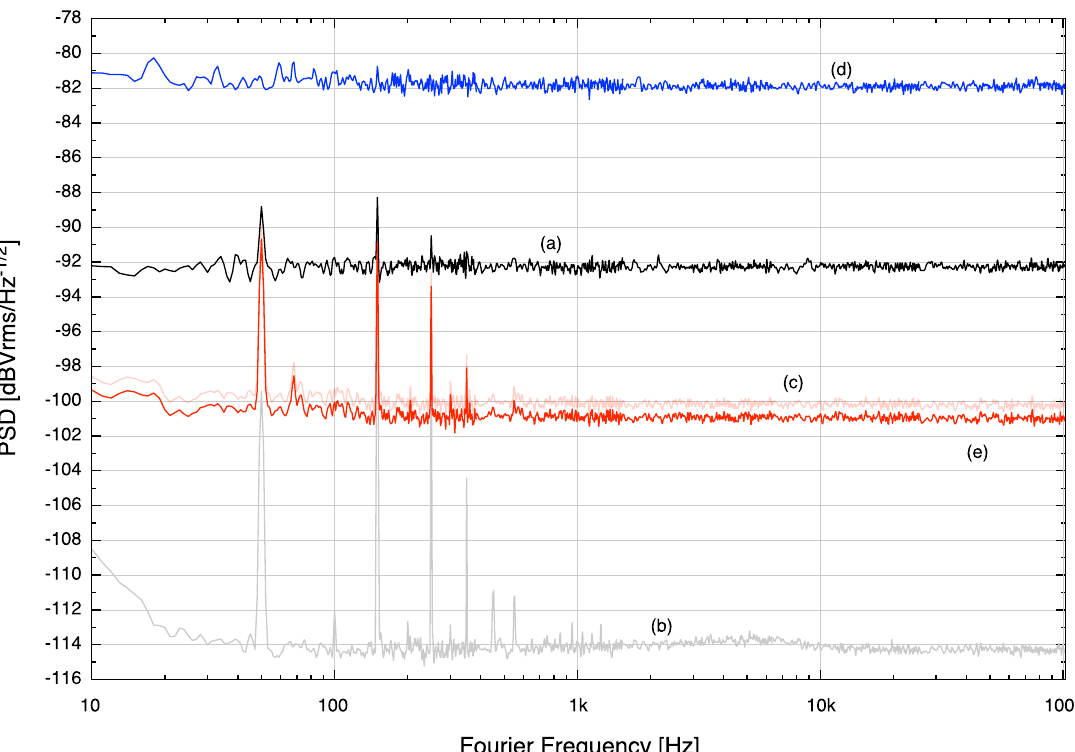
Figure 3. Noise measurements performed with the on-board diagnostic homodyne detector. All traces are combined of five FFT frequency windows acquired with the spectrum analyzer: 10–400Hz, 400Hz–1.6kHz, 1.6–6.8kHz, 6.8–25.2kHz, 25.2–102.4kHz. Data points are averaged rms values of 200, 400, 800, 800 and 800 measurements in these frequency ranges, respectively. Trace (a) represents the homodyne detector shot noise reference measured with a local oscillator beam of 2.1mW intensity. Trace (b) is the measured electronic dark noise which is not subtracted from the data. With an OPA pump power of 6mW a reduction of shot noise by up to 8.0dB could be measured (trace (c)), whereas the corresponding anti-squeezing was amplified by 10.4dB (trace (d)). By subtracting the optical loss which is introduced by the homodyne detector, one can derive an effective squeezing level of up to 9.0dB that is available for the injection into the Advanced Virgo detector (trace (e)). The anti-squeezing level changes only by 0.1dB due to this loss reduction and therefore increases to 10.5dB, indicating the high purity of the available squeezed